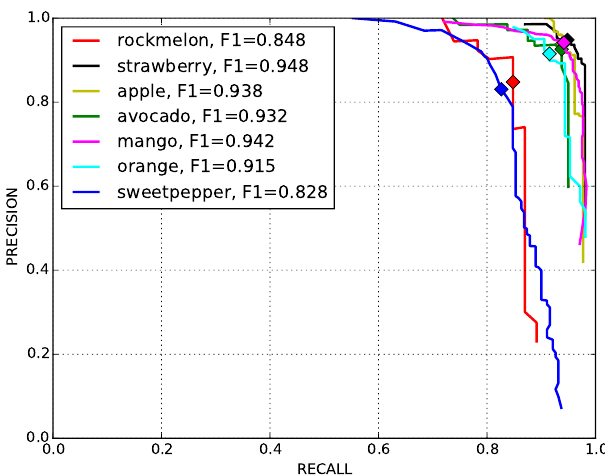
Figure 14. Quantitative performance evaluation for different fruits. The marks indicate the point where F1 scores are computed.